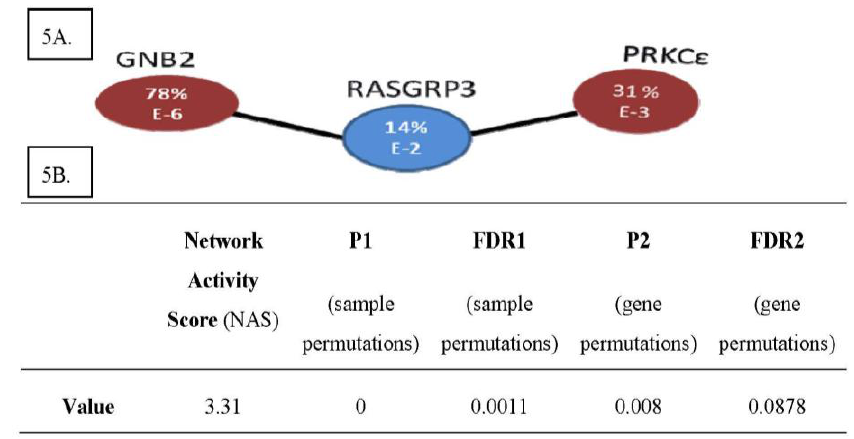
Figure 5. ( A ) The PRKCε-RASGRP3-GNB2 Network is Differentially Activated in Expression Profiles of Metastatic Osteosarcomas. ( B ) Differential Activity Score of PRKCε-RASGRP3-GNB2 Network. ( A ) Shown is the network of PRKCε-RASGRP3-GNB2 that is differentially activated in metastatic OS samples of the expression profiling screen. Red nodes are transcripts that are more abundant in metastatic samples, and blue nodes are less abundant in metastatic samples. Within each circle is the %-fold change in expression of metastatic samples vs. localized samples, and the order of magnitude of the p -value from the corresponding student’s t-test. ( B ) Shown are the relevant scores for the PRKCε-RASGRP3-GNB2 network, the results of the differential network activity analysis applied to expression profiles of MD-OS vs. LD-OS